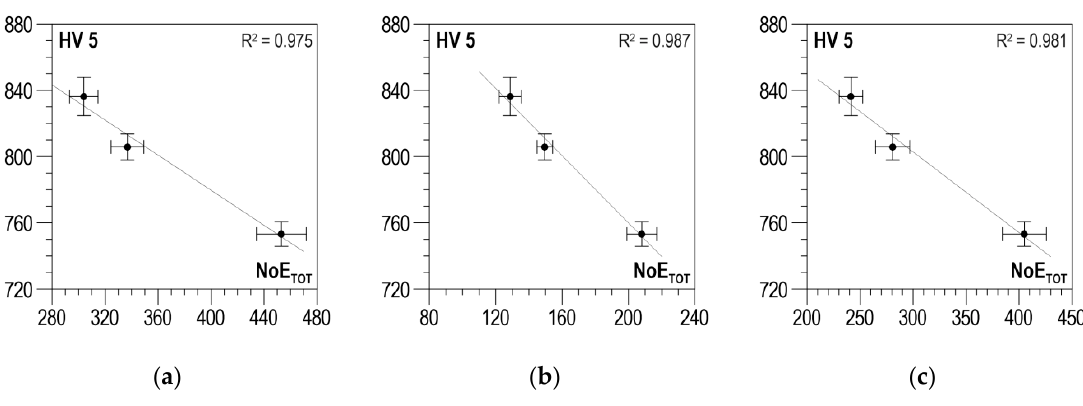
Figure 19. Linear correlations between NoE TOT and HV5 hardness—Configuration C3 ( a ) parallel direction, U g = 0.1 V; ( b ) normal direction, U g = 0.16 V; ( c ) absolute value, U g = 0.14 V.